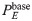
Long-range coupling strength C and background drive PEbase modulate firing rates and oscillation frequencies at baseline.(A) The time- and network-averaged population firing rate 〈E(t)¯〉 as a function of C and PEbase (units are arbitrary). (B) The network-averaged peak frequency of regional activity 〈fpeak〉 as a function of C and PEbase. (C) A segment of the activity of one brain area and (D) the corresponding power spectra of the same area at the working point denoted by the red dot in panels A and B (PEbase=0.553, C = 2.5). (E) A segment of the activity of one brain area and (F) the corresponding power spectra of the same area at the working point denoted by the orange dot in panels A and B (PEbase=0.57, C = 2.5). (G) A segment of the activity of one brain area and (H) the corresponding power spectra of the same area at the working point denoted by the yellow dot in panels A and B (PEbase=0.7, C = 2.5).